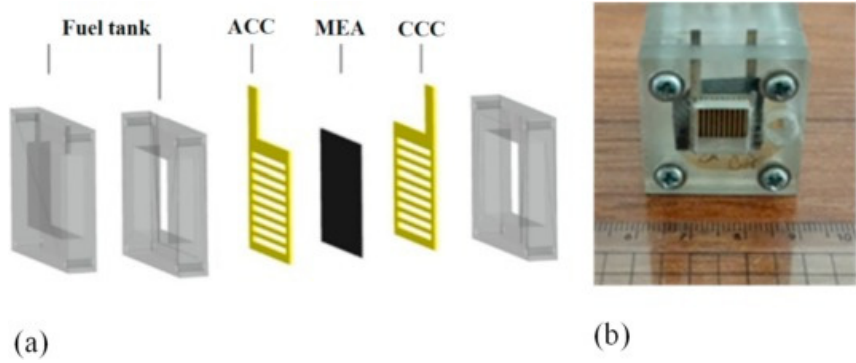
Figure 7. Assembled PS-DMFC: ( a ) schematic of the structure; ( b ) picture of the device. Reproduced from [111] with permission from Elsevier 2018.